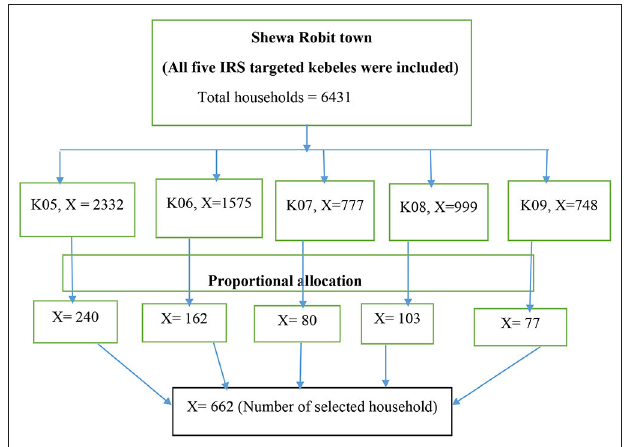
FIGURE 1 | Sampling procedure. K = Kebele, X = Households, IRS = Indoor residual